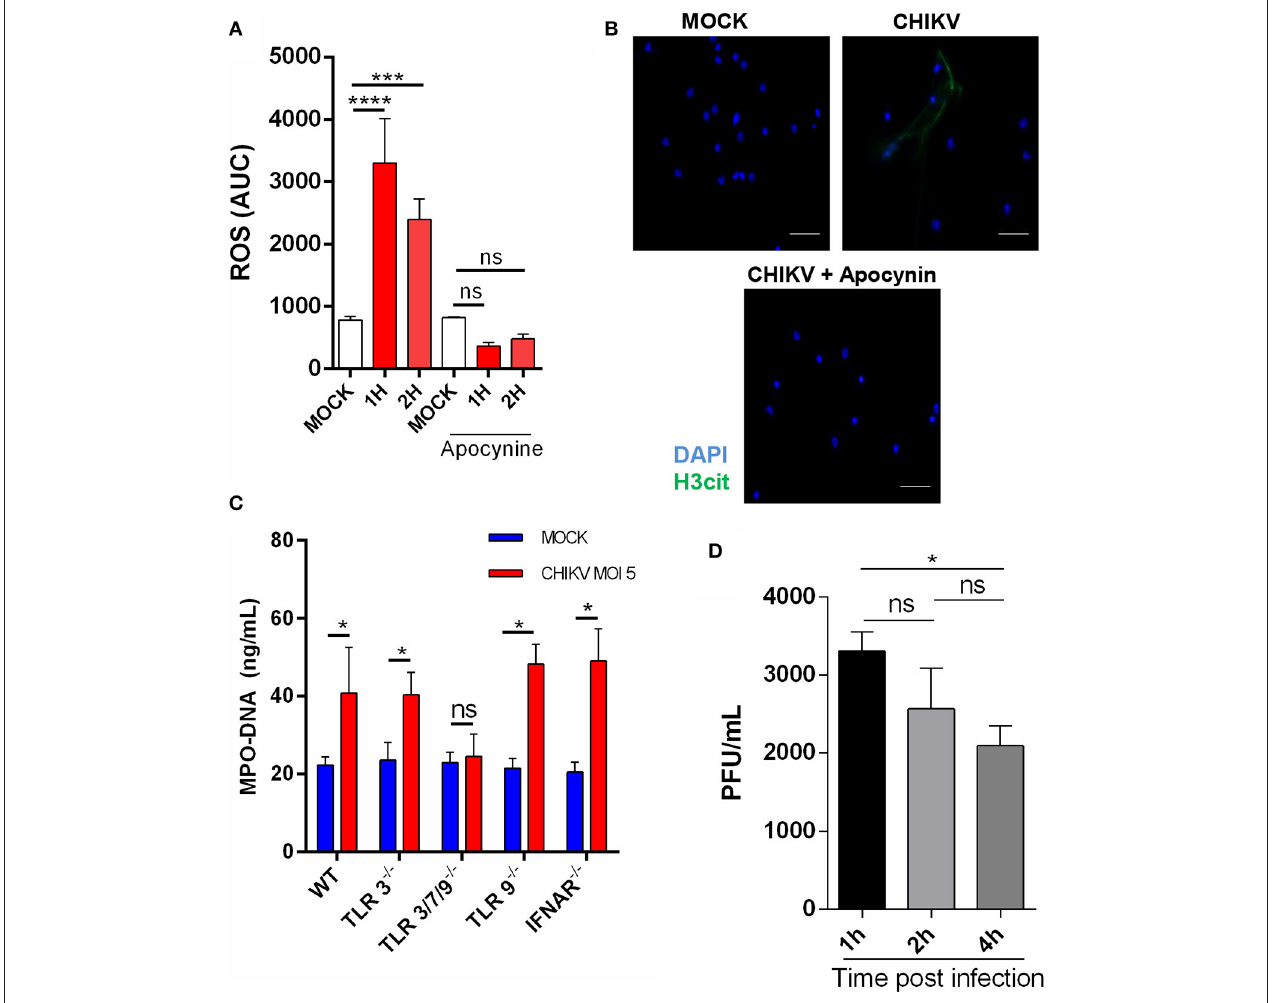
FIGURE 2 | CHIKV triggers TLR7- and ROS-dependent NETosis. (A) Production of ROS by mouse neutrophils incubated with CHIKV (MOI = 5) and treated or not with apocynin (300 µ m) for 30min prior to CHIKV incubation. (B) Representative image of an immunofluorescence assay of mouse neutrophils incubated with CHIKV (MOI = 5) and treated or not with apocynin (300 µ M) for 30min prior to CHIKV stimulation. Bars = 50 µ m. Magnification × 40. Samples were stained with DAPI ( blue ) and anti-H3 citrulline ( green ). (C) Quantification of NETs by MPO–DNA PicoGreen in the supernatant of TLR3 − / − , TLR3/7/9 − / − , TLR9 − / − , and IFNAR − / − mouse-isolated neutrophils after incubation with CHIKV (MOI = 5 for 4h). (D) RT-qPCR for CHIKV from neutrophils incubated with virus stocks after 1, 2, and 4h. Data are presented as mean ± SD ( n = 4 per group); * p < 0.05, *** p < 0.001, and **** p < 0.0001, assessed by one-way (A,D) or two-way ANOVA (C) with Bonferroni’s comparisons test. Representative results of two experiments performed